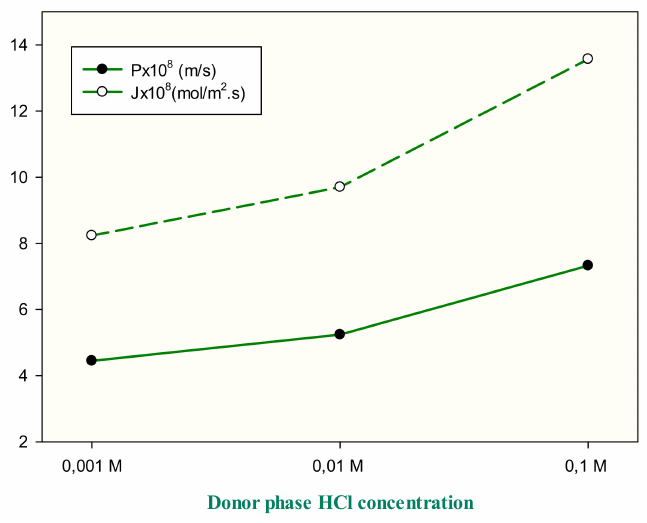
Figure 2. Effect of HCl concentration at the donor phase on the transport of